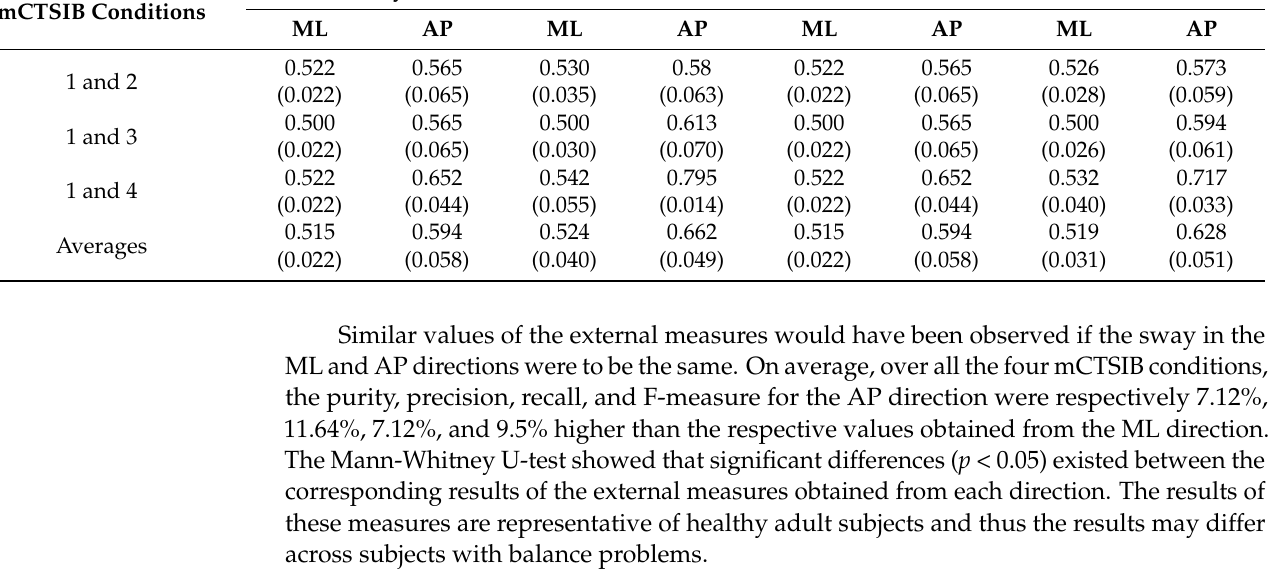
Table 1. Results of the median (interquartile range) values of the external measures for 30 clustering repetitions. mCTSIB